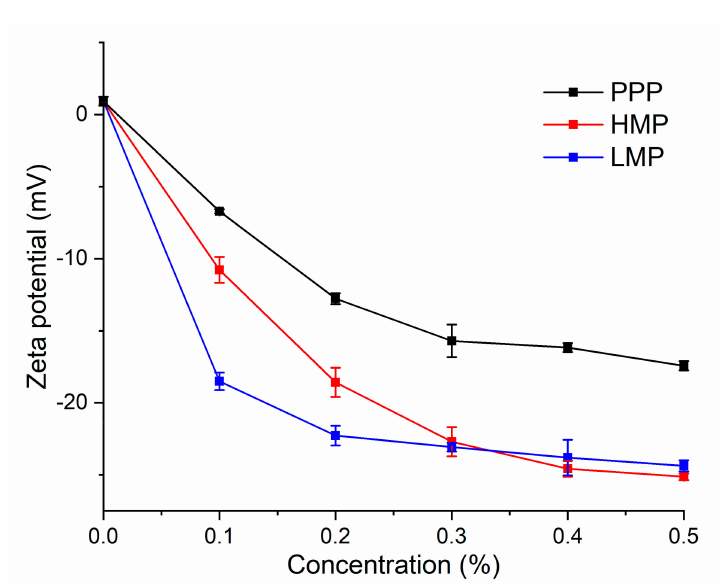
Figure 1. Zeta potential of AMDs as a function of stabilizers concentration (from 0 to